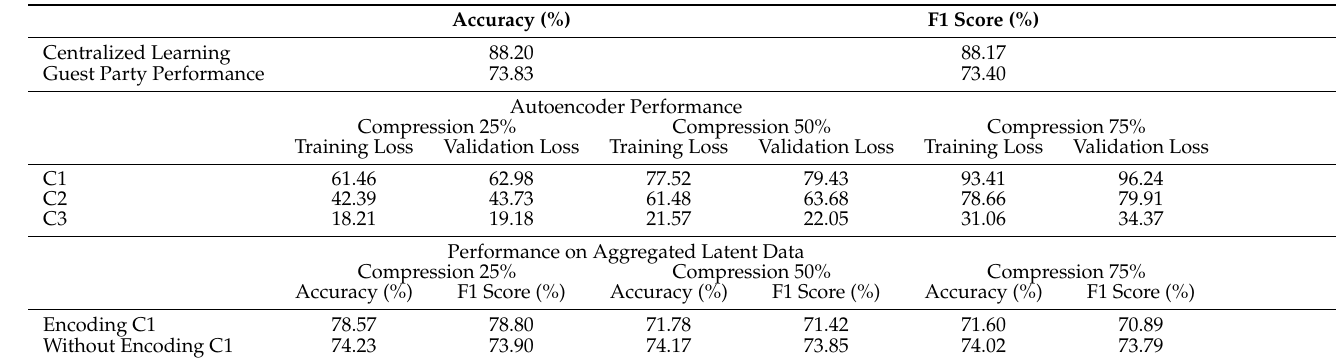
Table 9. Experimental Results on Rice MSC